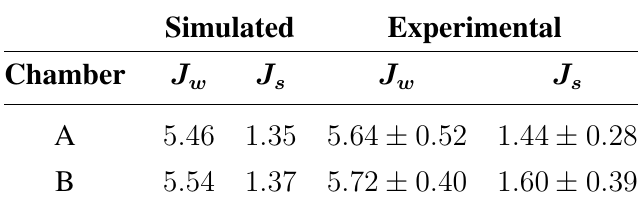
and J are g (m 2 h) − 1 s w